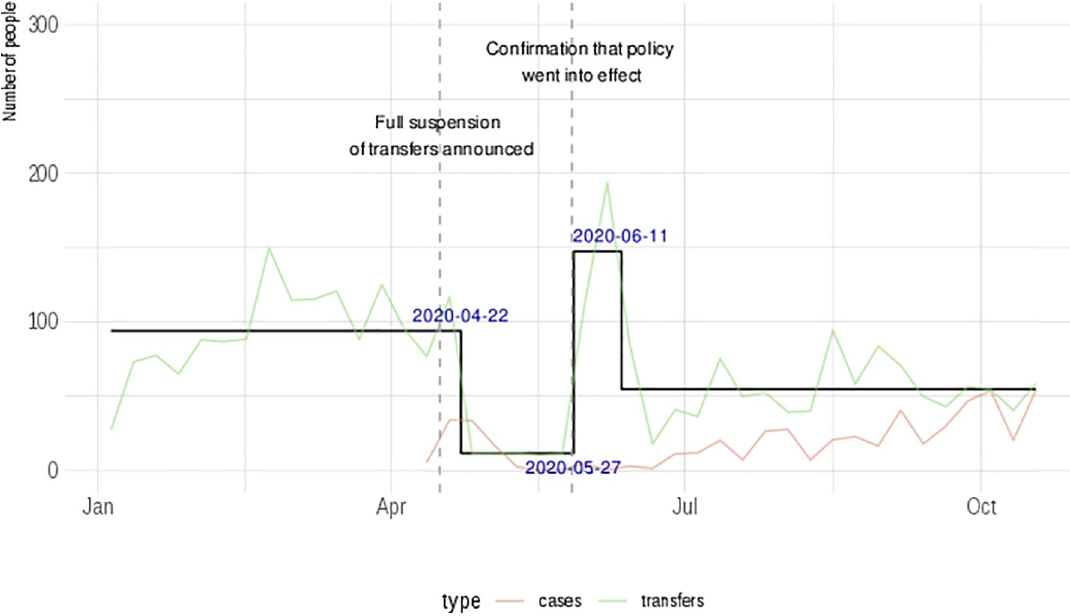
Fig 1. Number of incarcerated individuals transferred between prisons and number of COVID-19 cases within a single state prison system in 2020. Green line represents raw weekly average per-day transfers, red line represents raw weekly average per-day COVID-19 cases, black line represents the output of the change point detection model. The two dashed lines represent the timing of a state policy change, and a confirmation of that change at a later date.